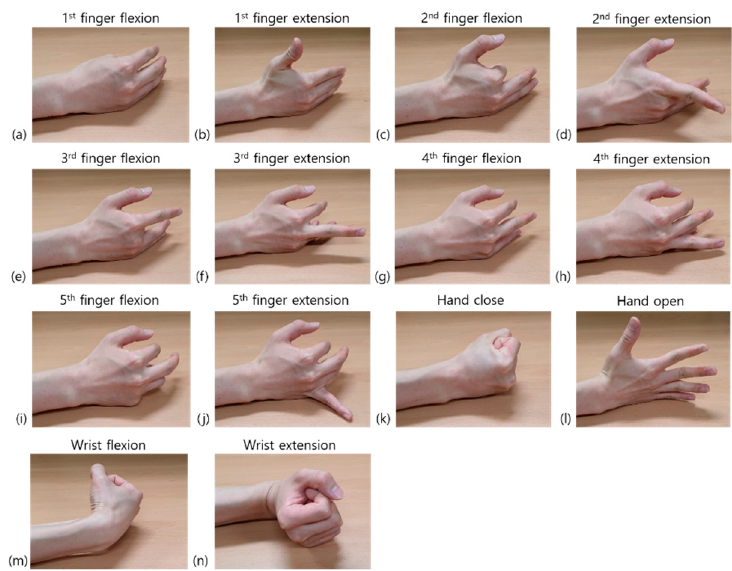
Figure 2. The 14 different hand movements that were used in this study. ( a ) 1st finger flexion. ( b )